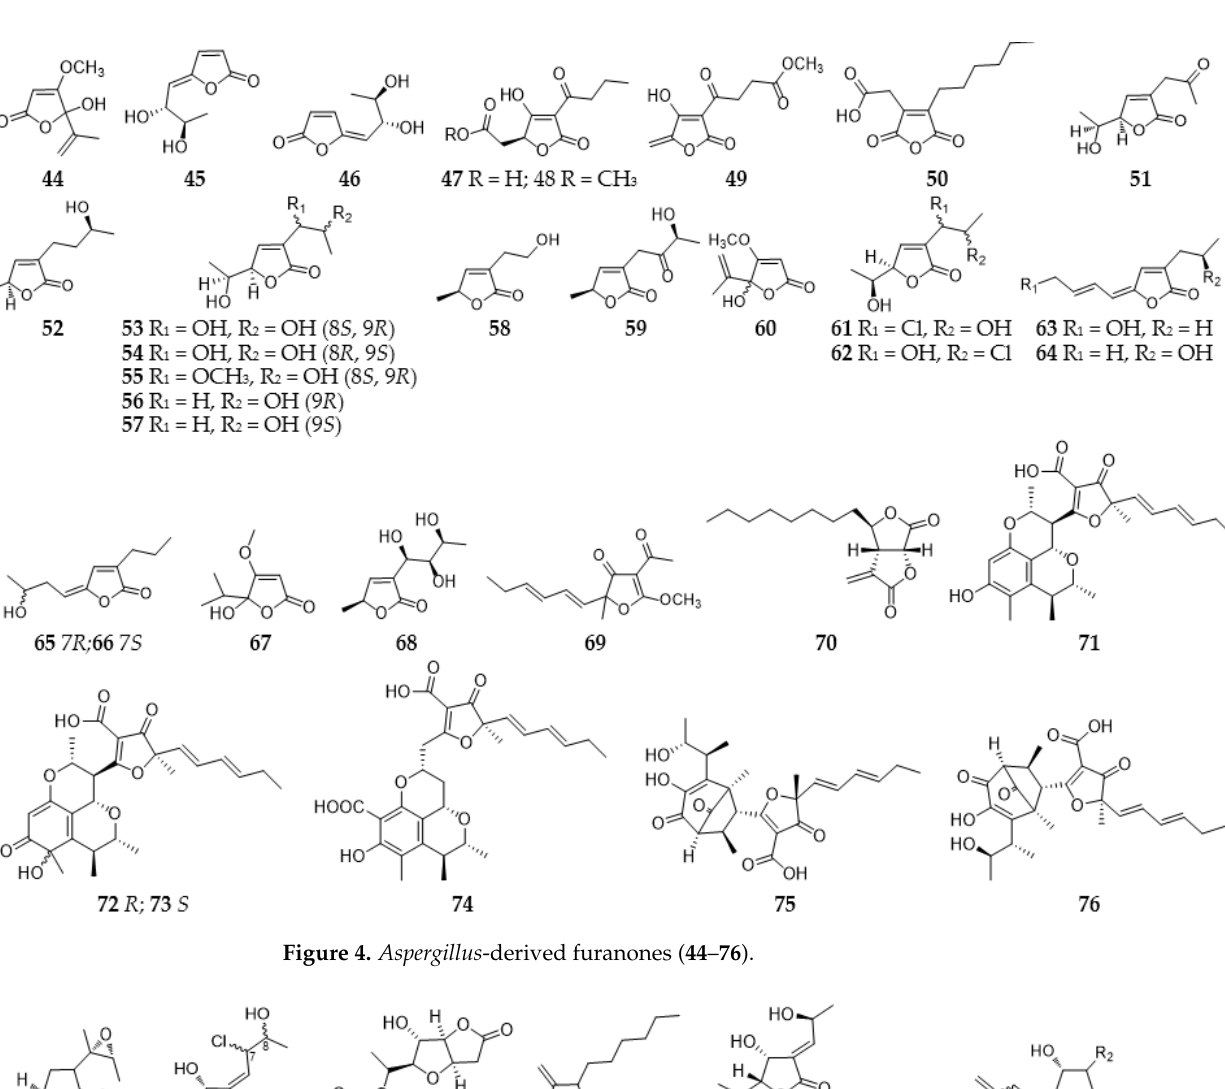
Figure 3. Aspergillus -derived furans and benzofurans ( 32 – 43 ).